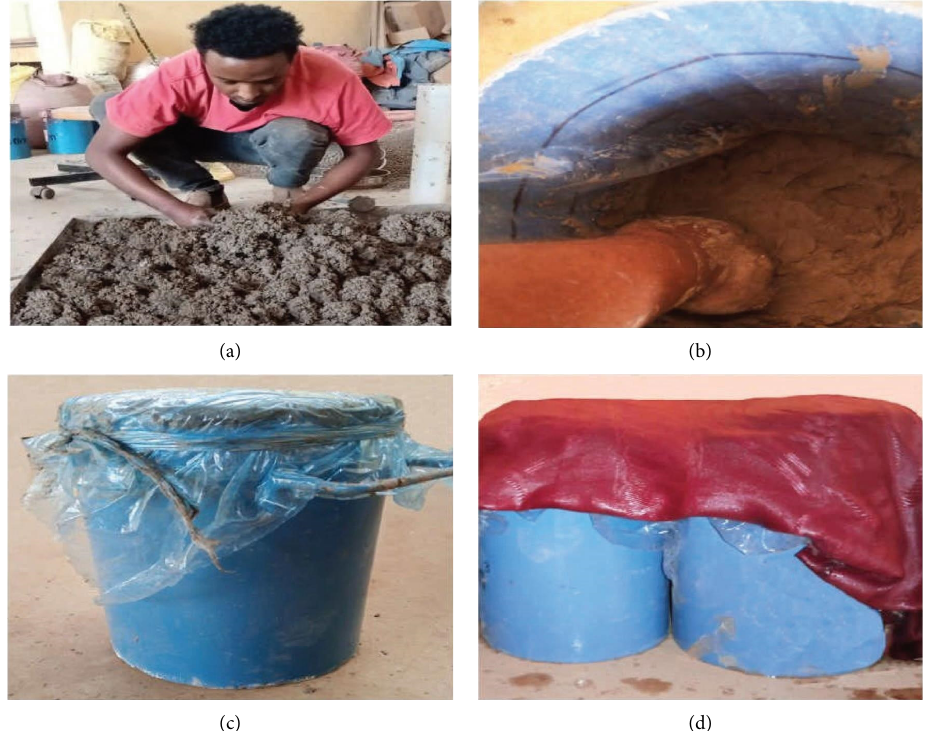
Figure 6: Preparation of soft clay bed: (a) mixing air-dried clay soil, (b) placing and controlling during flling test tank with clay paste, (c) tightening with a plastic sheet to keep the moisture content of the clay bed, and (d) covering with a wet cloth for 48 hours.